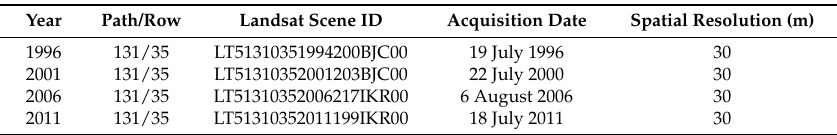
Table 1. Metadata of Landsat Thematic Mapper (TM)/ETM+ (Enhanced Thematic Mapper Plus) images cover the Linxia rangeland, northwest China.